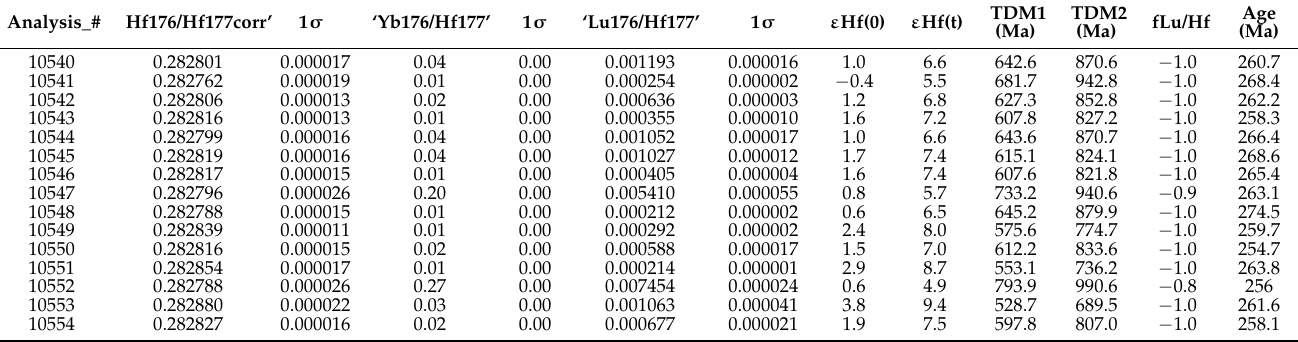
Table A2. Zircon LA-MC-ICP-MS Lu-Hf isotope analytical results for the hornblende gabbro of the Baogeqi gabbro